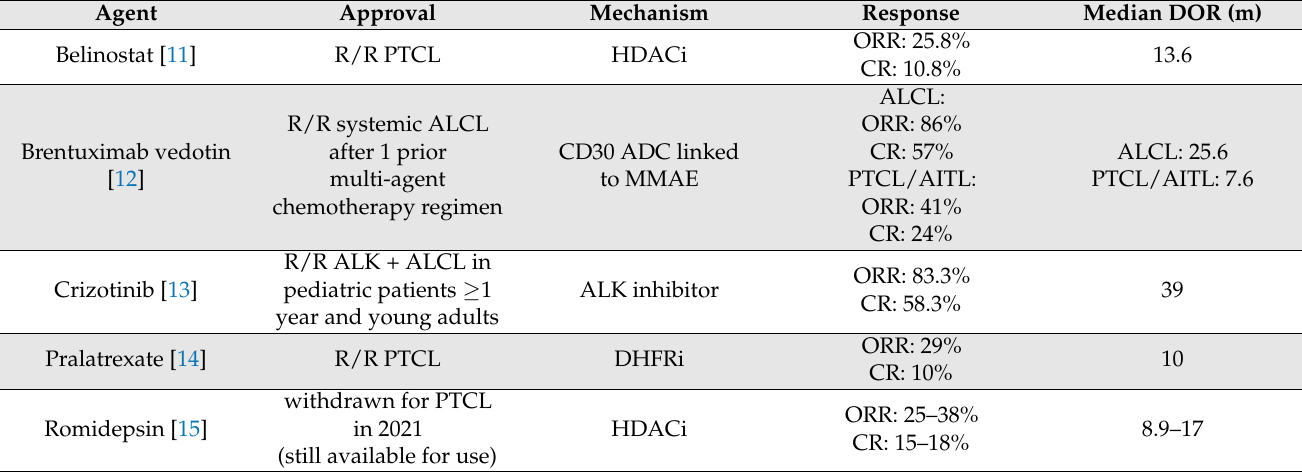
Table 2. Currently approved therapies for relapsed/refractory nodal peripheral T-cell